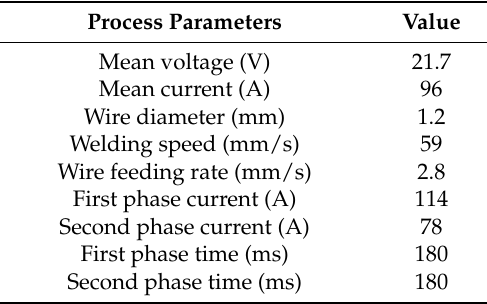
Figure 1. Schematic diagram of the current waveform and longitudinal sections of the double pulsed-gas metal arc welding (DP-GMAW) weld pool and the inclination of the welding torch. Table 2. Welding process parameters for DP-GMAW.